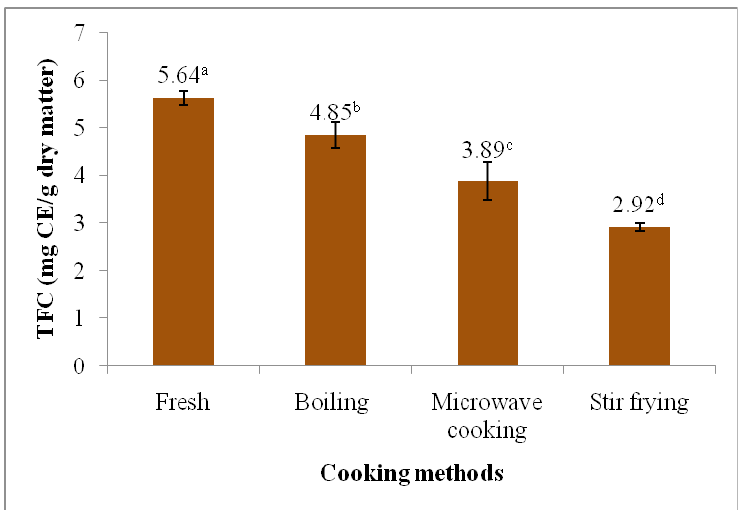
Figure 2: Total flavonoid content of fresh and cooked tomato. Data are presented as mean ± standard error. Mean values with different superscripts are significantly different at p< 0.05 by analysis of variance followed by Duncan’s multiple range test.